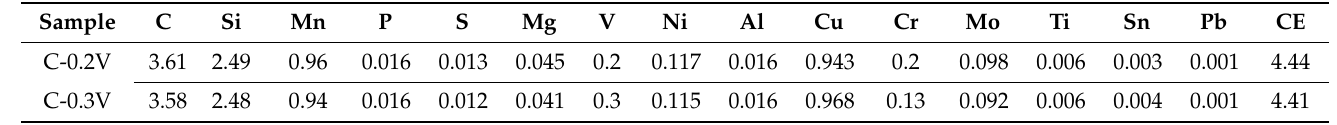
Table 3. Chemical composition of camshafts alloyed with V (wt.